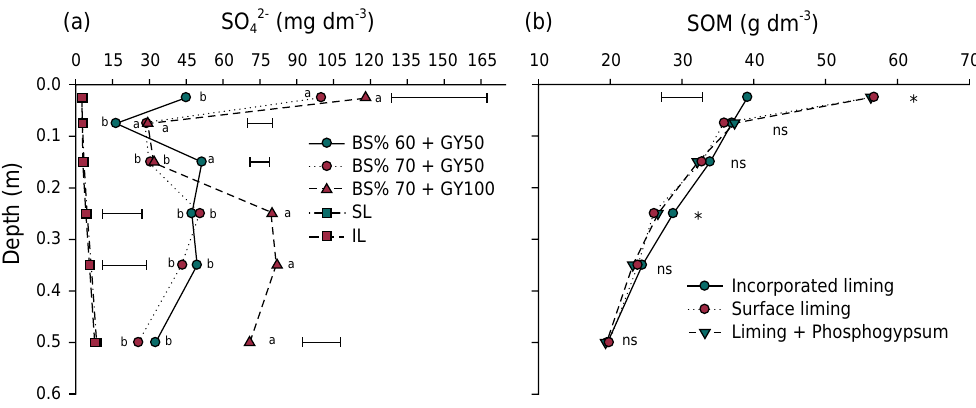
Figure 6. Sulfate content (S-SO 42- ) at different depths (a) after surface and incorporated liming (n = 16) and liming + phosphogypsum (4). The horizontal bars indicate the DMS between treatments with phosphogypsum vs lime application determined by a Dunnett test (p<0.05). Different letters at the same depth indicate a significant difference between phosphogypsum treatments based on Tukey’s test (p<0.05). Soil organic matter (SOM) content (b) after lime application on the surface, via incorporation, and with phosphogypsum. * and ns indicate a significant difference and absence of effect at the same depth, respectively, determined by an F test (p<0.05). The horizontal bar indicates the DMS between the mode of limestone application and additional treatments